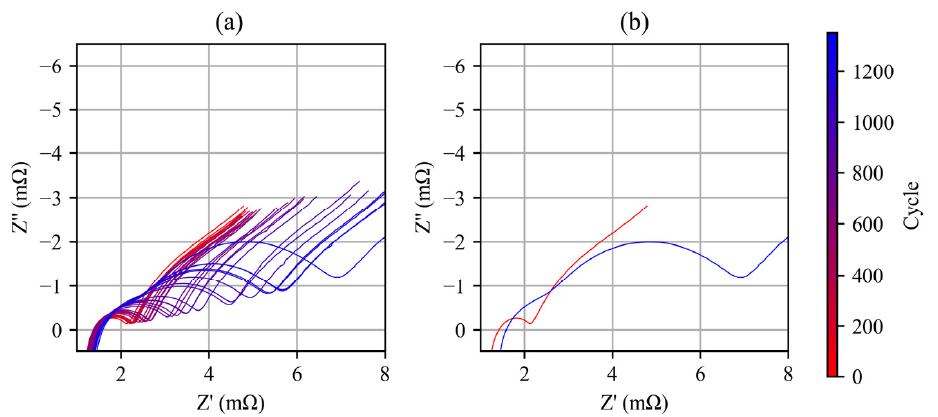
Figure 13. ( a ) Evolution of the Nyquist diagram of cell #7 during aging cycle; ( b ) Nyquist diagrams of cell #7 before and after aging cycles.